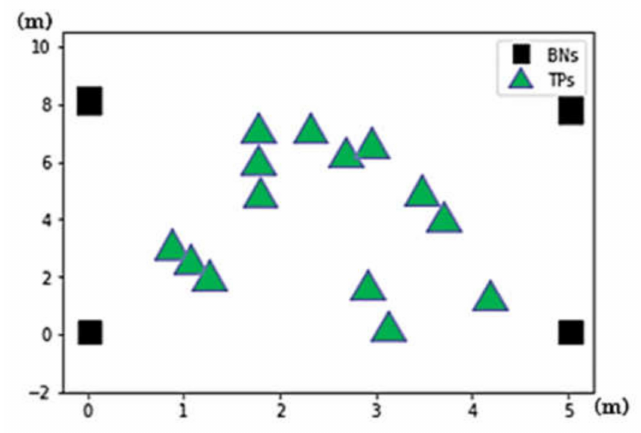
Figure 6. The Illustration of 12 test points (TPs) and 4 beacon nodes (BNs).